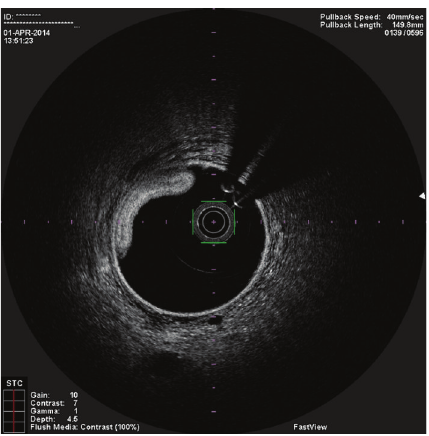
Figure 2: OCT image showing two guidewires in the false